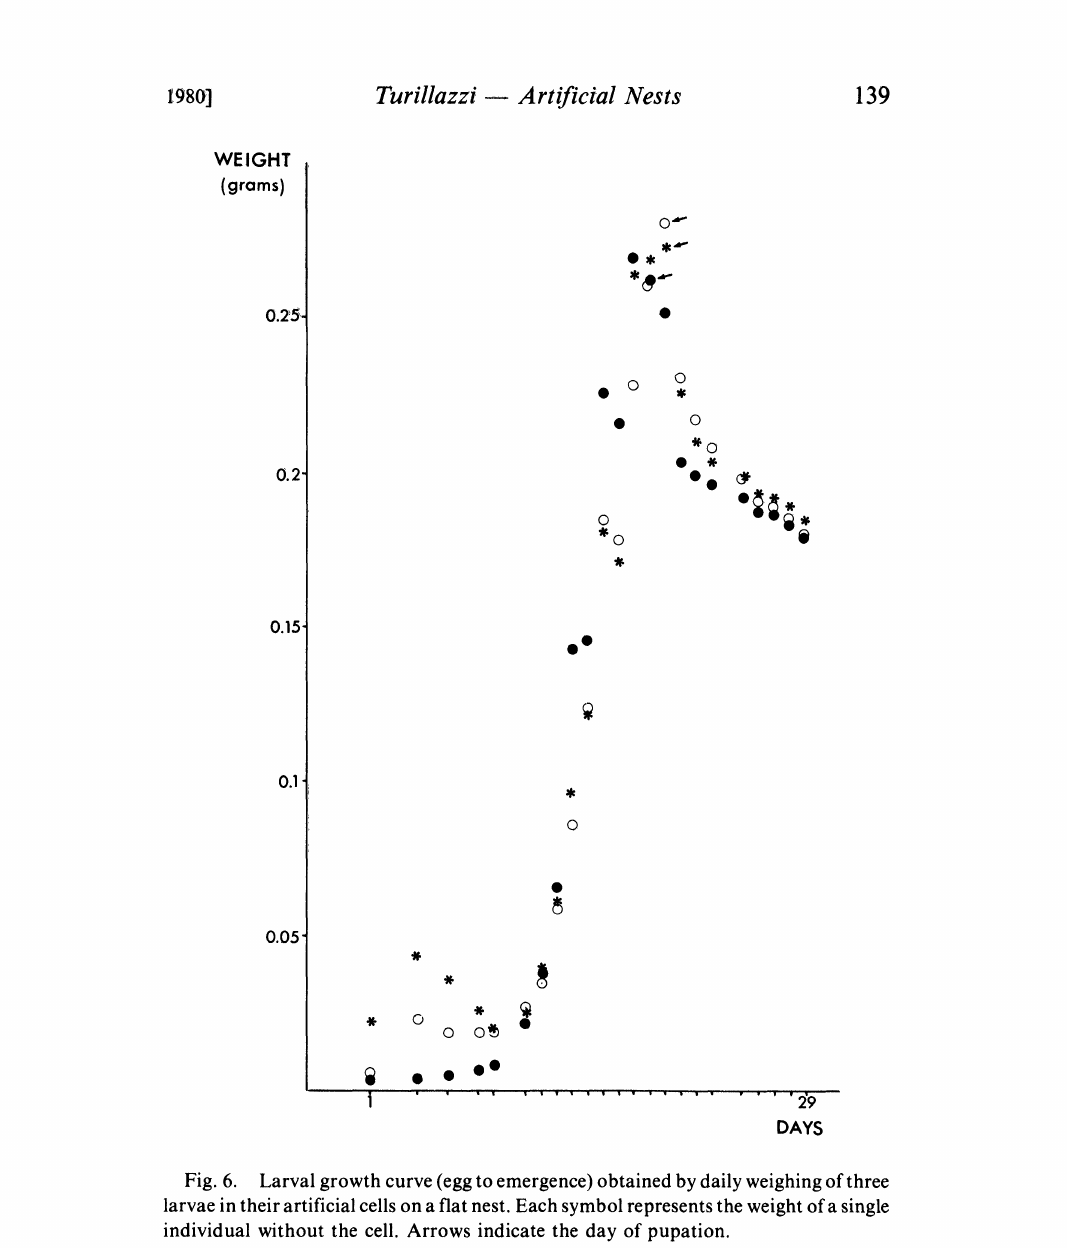
Fig. 6. Larval growth curve (egg to emergence) obtained by daily weighing ofthree larvae in their artificial cells on a flat nest. Each symbol represents the weight of a single individual without the cell. Arrows indicate the day of